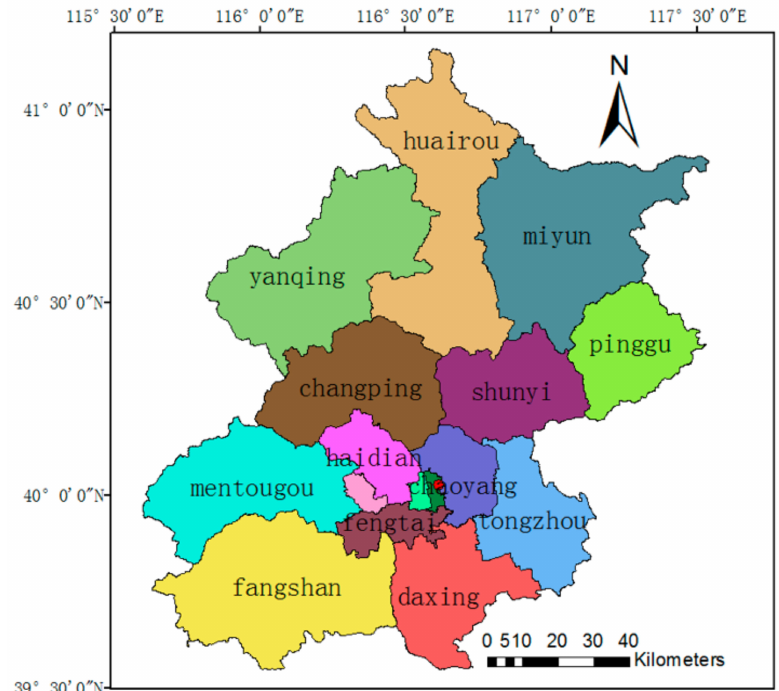
Figure 1. Administrative map of